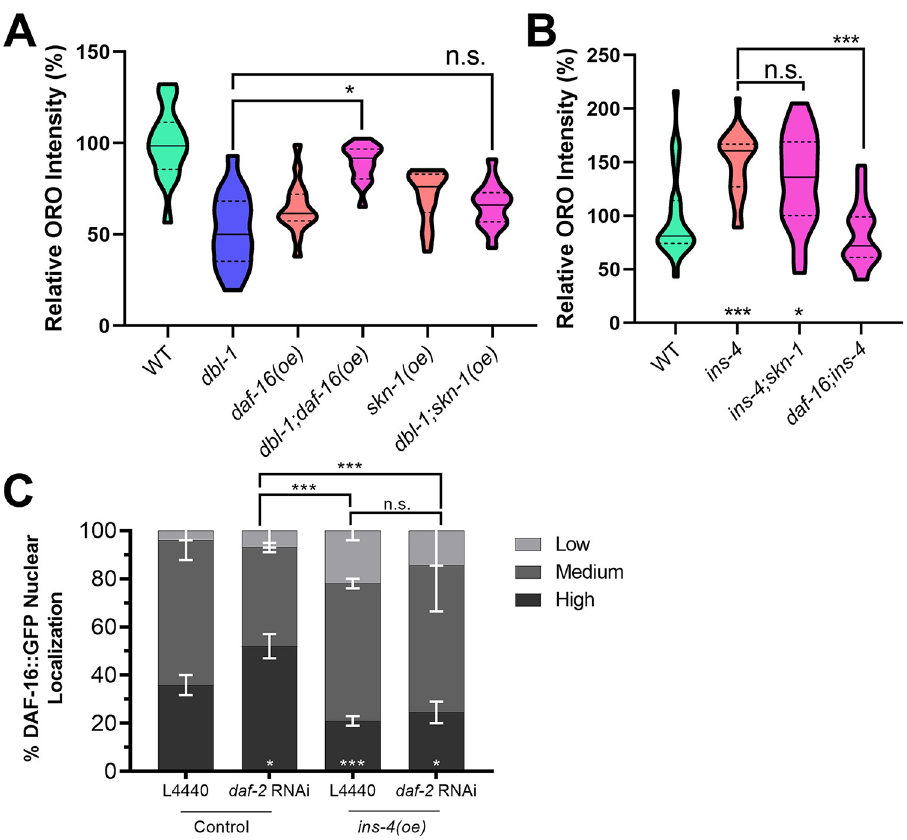
Fig 3. DAF-16/FoxO but not SKN-1/Nrf mediates BMP-insulin regulation of lipid accumulation. A) Overexpression of DAF-16::GFP rescues the low-fat phenotype of dbl-1 mutants while overexpression of SKN-1::GFP does not. B) Loss of daf-16 blocks the high-fat phenotype of ins-4 mutant animals. Animals were stained at L4 stage with the neutral lipid dye Oil Red O. Images taken at 400X, camera settings were kept constant between all strains. Quantification was done for equivalent regions of the intestine just posterior to the pharynx. n.s. not significant, � p value < 0.05, ��� p value < 0.001, solid lines denote the median, dashed lines denote quartiles. C) DAF-16::GFP nuclear localization in control and ins-4(oe) strains with empty vector or daf-2(RNAi) treatment. but less than that of wild type treated with daf-2 RNAi (p < 0.0001). Interestingly, upon treat- ment with daf-2 RNAi, localization of SKN-1::GFP in dbl-1 mutants was not significantly dif- ferent from those treated with the empty vector (p = 0.8694) (Fig 2C and 2D). This outcome contrasts with the results with DAF-16::GFP. Instead, the responsiveness of SKN-1::GFP to the reduction of DAF-2/InsR was reduced in the dbl-1 mutant background.